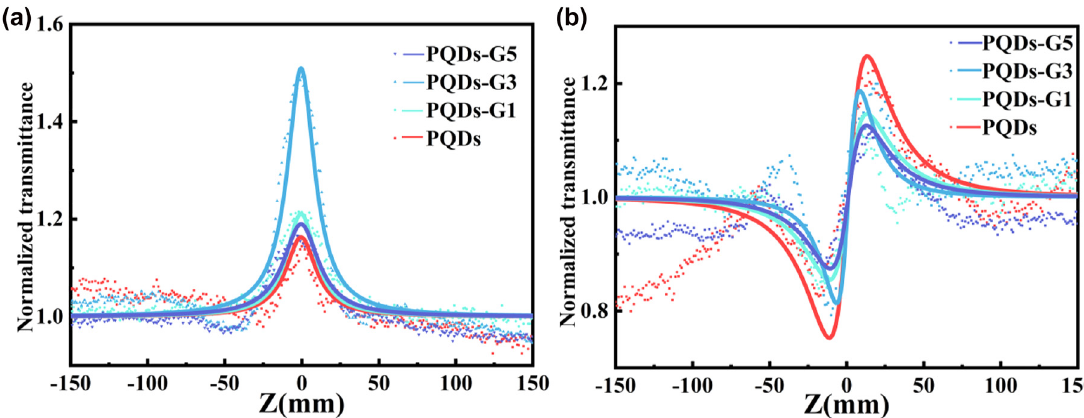
Figure 5: (a) Open aperture Z-scan curves (a) and closed-aperture/open-aperture Z-scan curves (b) of PQDs and PQDs-G composites.